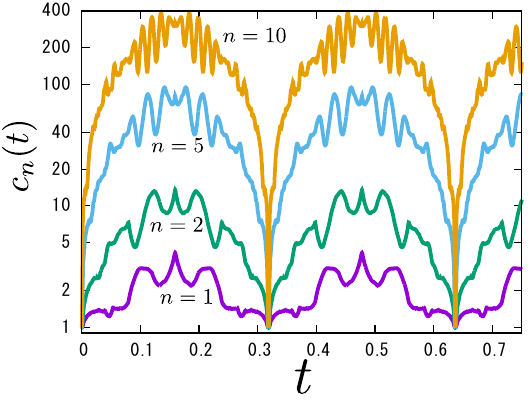
Figure 2 . Microcanonical out-of-time-order correlators for the particle in a 1D box ( L = 1). spectrum for the particle in a box is commensurable: E n is proportional to the integer n 2 . By using eq. (3.8), one can show that the all E kl appearing in r.h.s. of eq. (2.7) become π 2 odd integer and thus, OTOCs have periodicity ∆ t = 1 /π ×